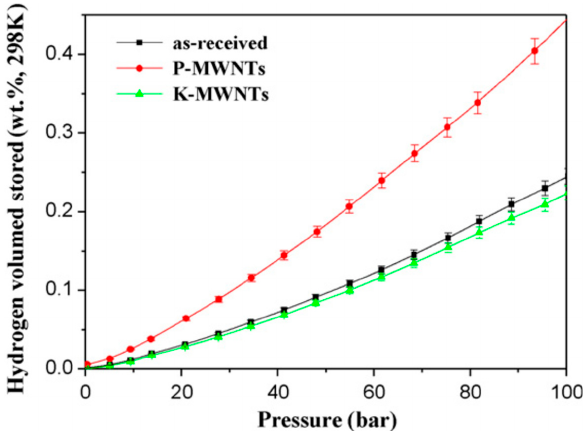
Figure 2. Hydrogen storage behaviors of the chemically-treated multi-walled carbon nanotube (MWCNTs), where P-MWCNTs are H 3 PO 4 -treated MWCNTs, K-MWCNTs are KOH-treated MWCNTs